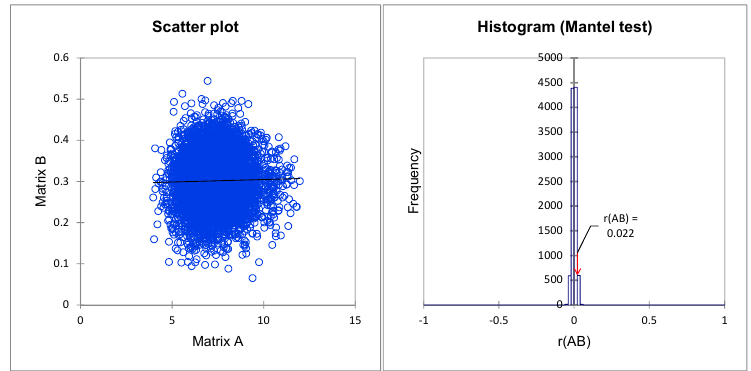
Figure 4. Correlation analysis between dissimilarity matrices of clonal genetic relatedness from 16 SSR markers and clonal genotypic values of 28 phenotypic